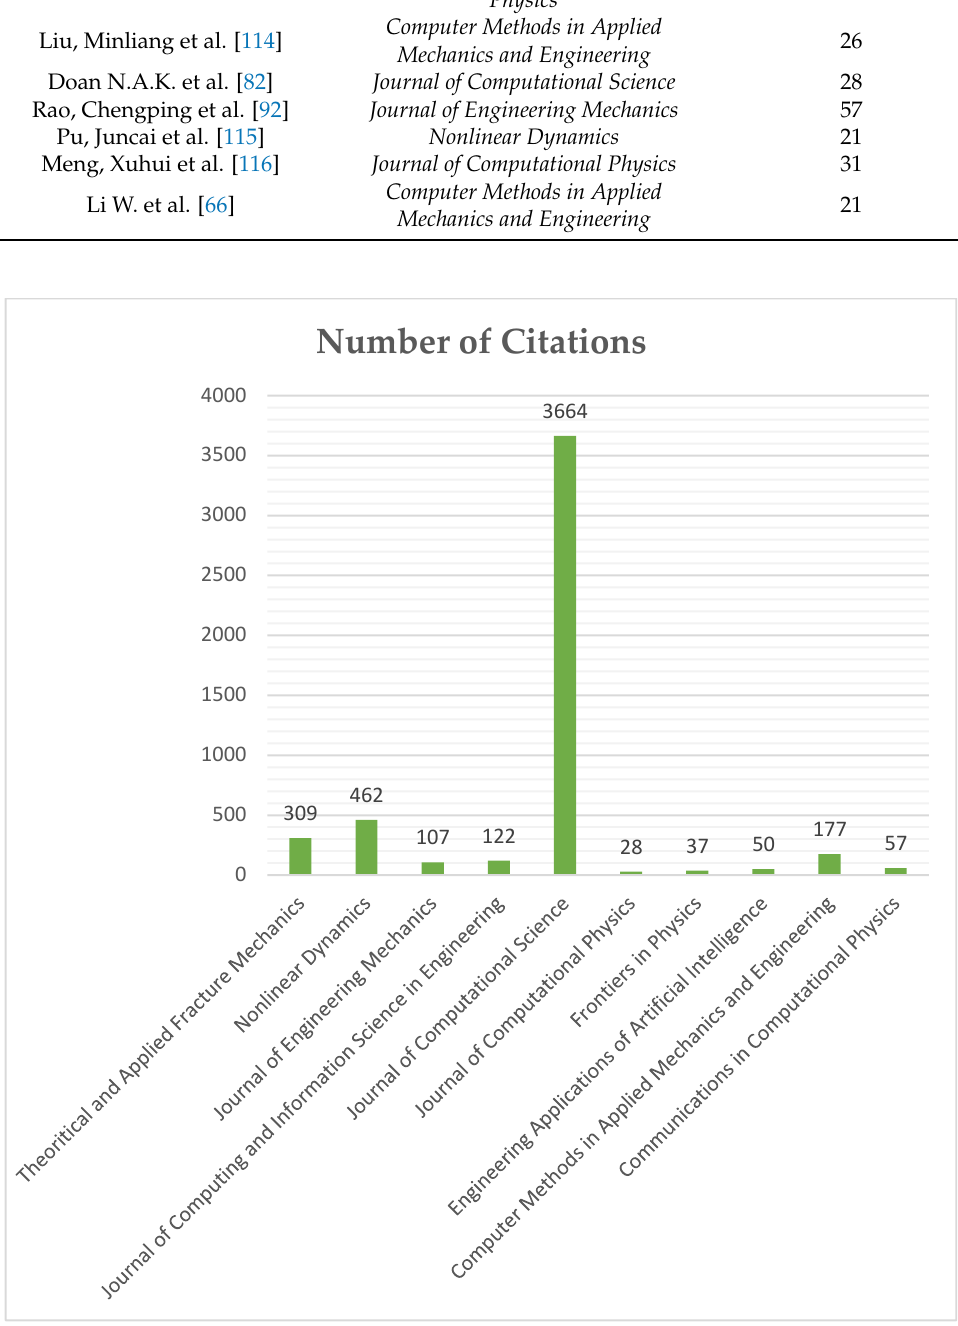
Figure 7. Journals with the most citations.